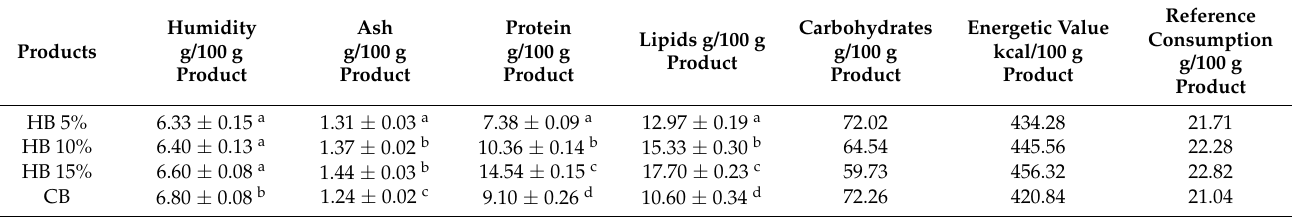
Table 7. Proximate composition of